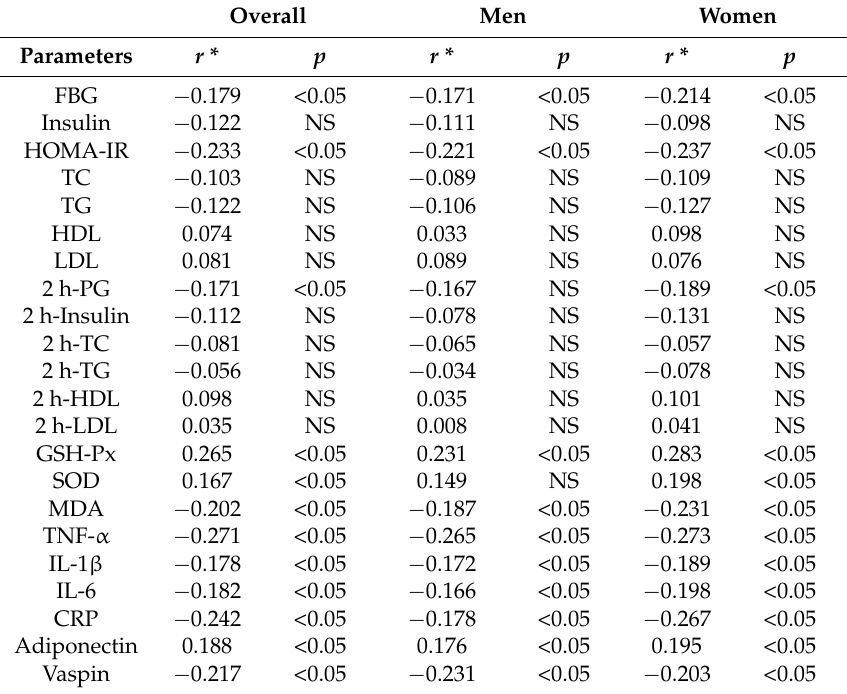
Table 5. Associations between dietary histidine and metabolic profile, inflammation and oxidative stress in overweight/obese